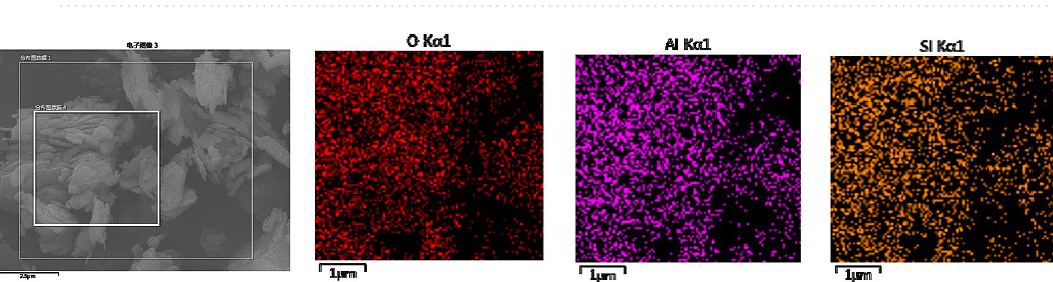
Figure 2. SEM test chart before and after the adsorption of kaolinite, ( a ) Original sample ( b ) 3 mmol/L SDBS after adsorption ( c ) 4 mmol/L SDBS after adsorption ( d ) 5 mmol/L SDBS after adsorption.